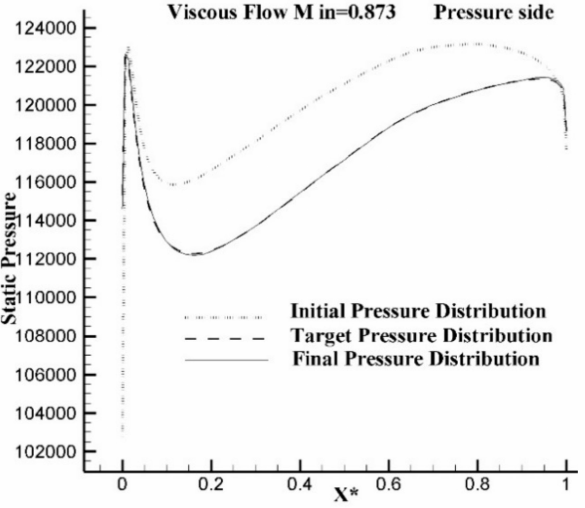
Figure 6. Initial, target, and final pressure distributions on the pressure surface versus non- dimensionalized X*—coordinate, in the validation of original UESA at AOA = 1 ◦ (Mach inlet =